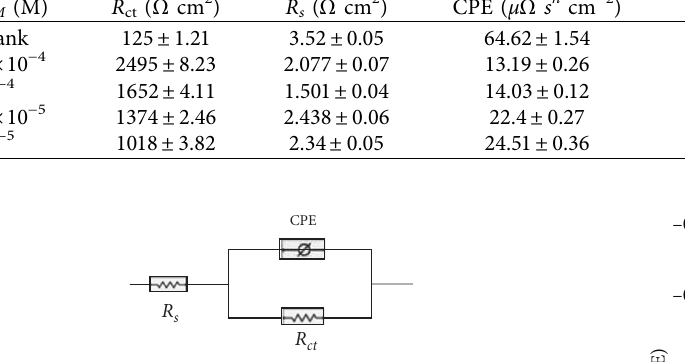
Figure 4: Equivalent circuit model of EIS.